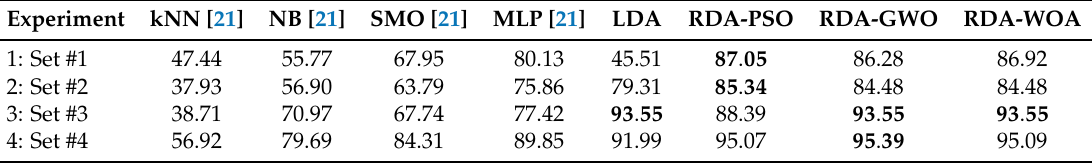
Table 2. Correct classified ratio